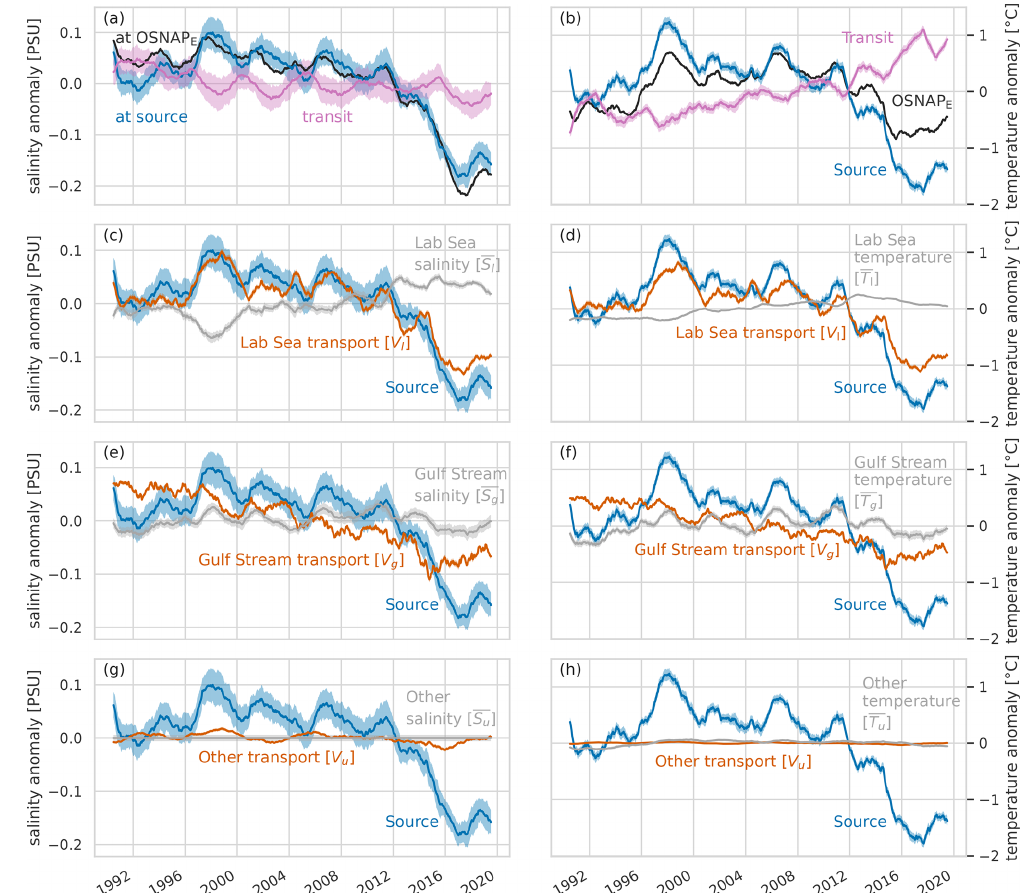
Figure 7. Relative contributions of specific causes to the salinity (a, c, e, g) and temperature (b, d, f, h) changes observed at OSNAP E − 37W − 500m . These are plots of 1-year running mean salinity and temperature anomalies. We see that, for salinity (a) , the overall freshening at OSNAP E − 37W − 500m (black line) closely follows the freshening of the combined sources (blue line), with a small additional contribution from changes during transit (pink). Temperature (b) shows in-transit changes (pink) opposing source changes (blue). In the panels below those, the contributions of six individual processes (orange and grey lines) to the overall source characteristics (blue lines) are estimated by holding the other five processes at their mean values (see Eq. 7). These six processes are: volume transport variability (orange lines, V l ,V g ,V u ) and salinity/temperature variability (grey lines, S l ,T l ,S g ,T g ,S u ,T u ) for the Labrador Sea source (c, d) , Gulf Stream source (e, f) , and other source waters (g, h)